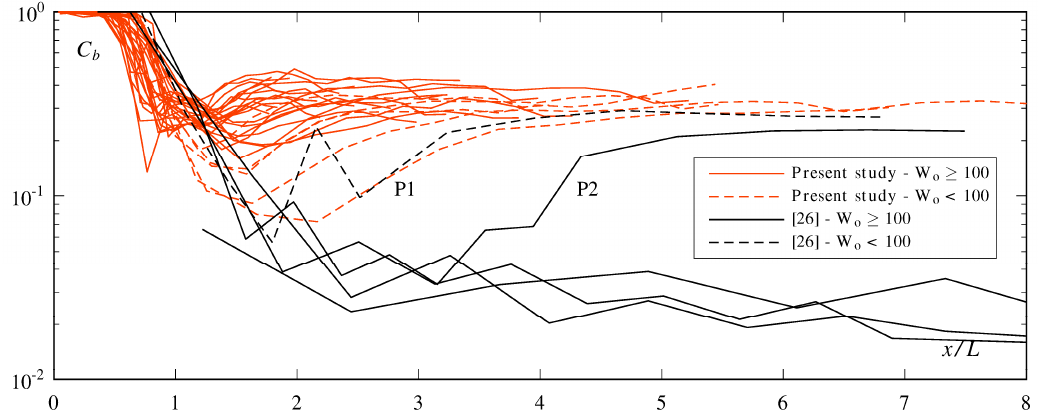
Figure 12. Bottom air concentration C b comparison of all present study tests for φ = 50° with those of [26].